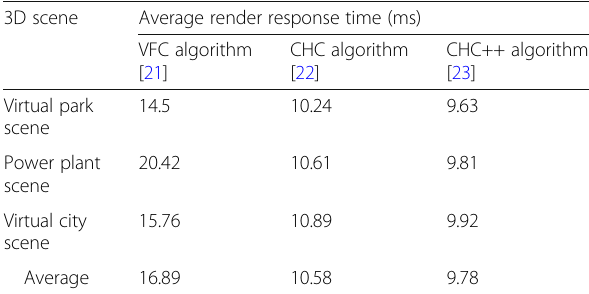
Table 3 Average response time of each algorithm after system